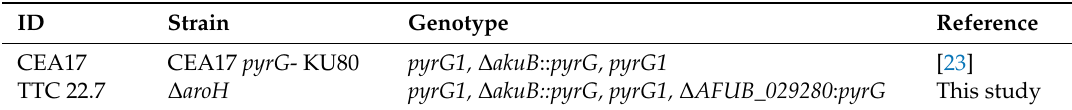
Table 1. Fungal Strains used in this study.